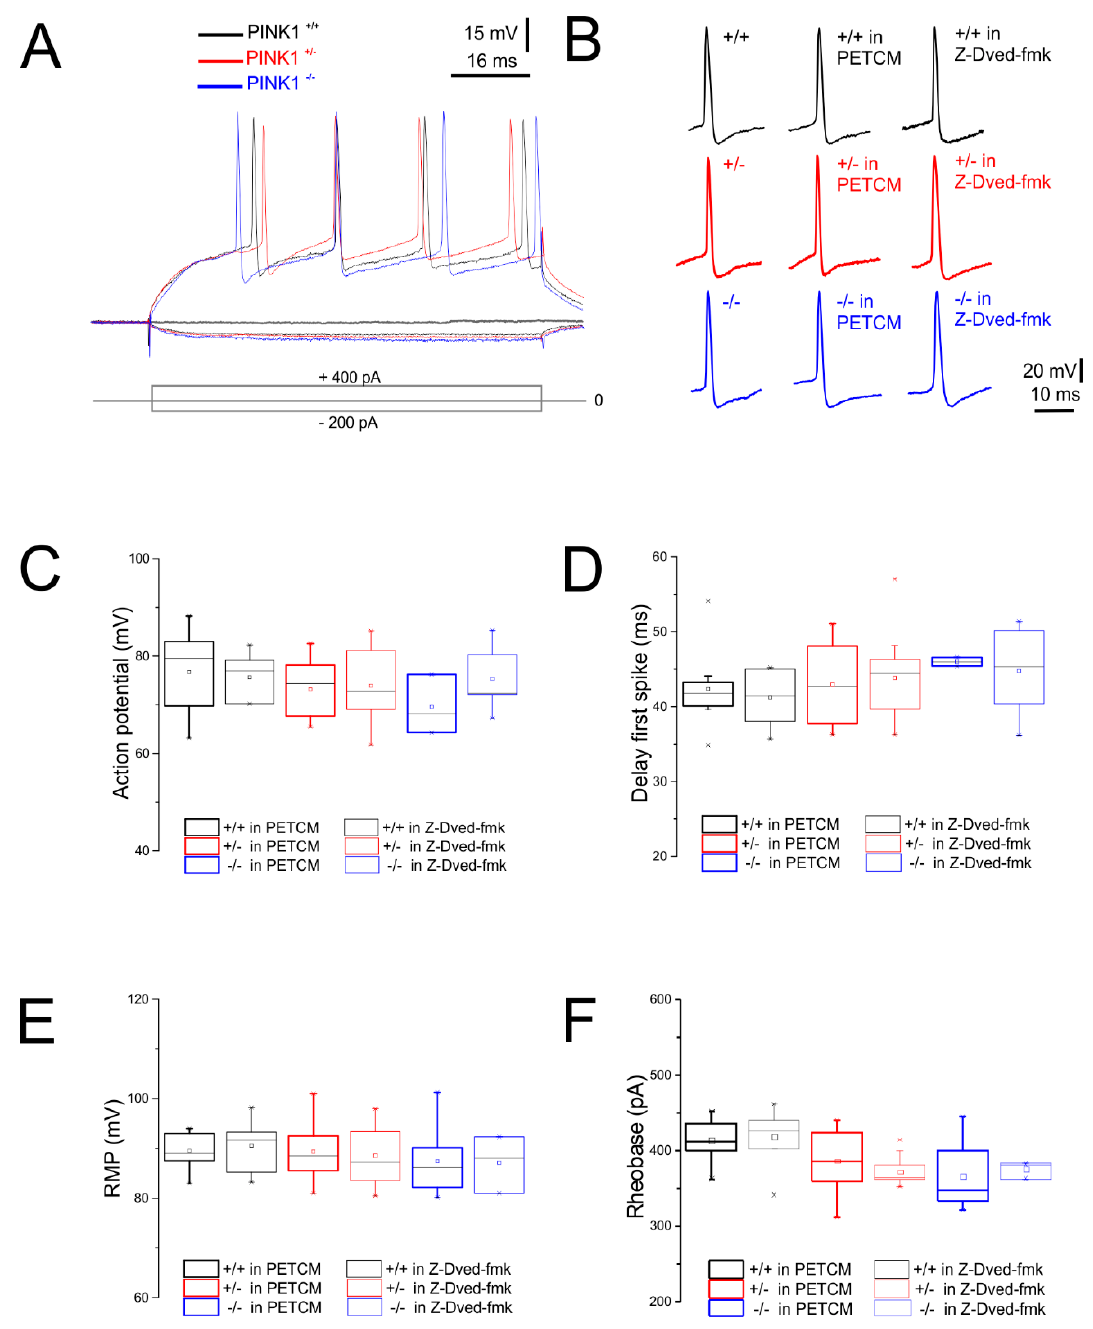
Figure 1. Intrinsic membrane properties of medium spiny neurons (MSNs) in phosphatase and tensin homolog (PTEN) induced kinase 1 (PINK1) mice after pretreatment with caspase-3 inhibitor and caspase-3 activator. ( A ) Superimposed traces showing voltage responses to current steps in both hyperpolarizing ( − 200 pA, 80 ms) and depolarizing ( + 400 pA, 80 ms) direction from PINK1 +/+ (black trace), PINK1 +/ − (red trace), and PINK1 − / − (blue trace) MSNs. No significant di ff erences were observed between the three genotypes. ( B ) Representative single action potentials recorded from MSNs both in basal condition and after treatment with the caspase-3 inhibitor Z-Devd-fmk (5 µ M) or with the caspase-3 activator α -(Trichloromethyl)-4-pyridineethanol (PETCM 30 µ M) in all PINK1 genotypes. We did not observe significant di ff erences between groups, in terms of upward spike, firing threshold, and half amplitude duration. ( C – F ) Whisker plots showing ( C ) action potential amplitude (PINK1 +/+ : 77.00 ± 3.8 mV; PINK1 +/ − : 78.4 ± 3.6 mV; PINK1 − / − : 79.4 ± 4.02 mV; n = 9 for each group; one- way analysis of variance (ANOVA) p > 0.05), ( D ) delay to first spike (PINK1 +/+ : 40.65 ± 1.99 ms; PINK1 +/ − : 42.13 ± 1.6 ms; PINK1 − / − : 44.23 ± 2.01 ms; n = 9 for each group; one-way ANOVA p > 0.05),